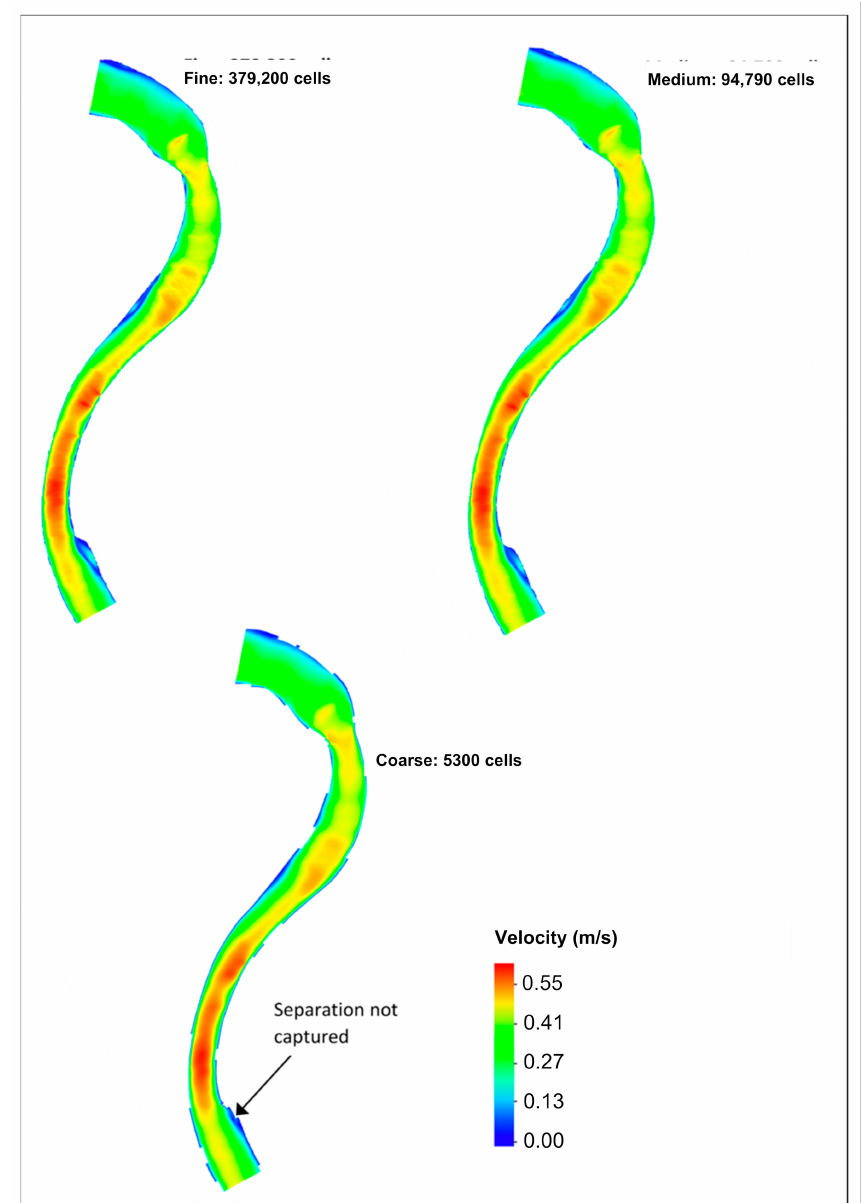
Figure 11. Velocity field contours for fine, medium and coarse grid sizes over the complete physical model and SRH-2D model domains.